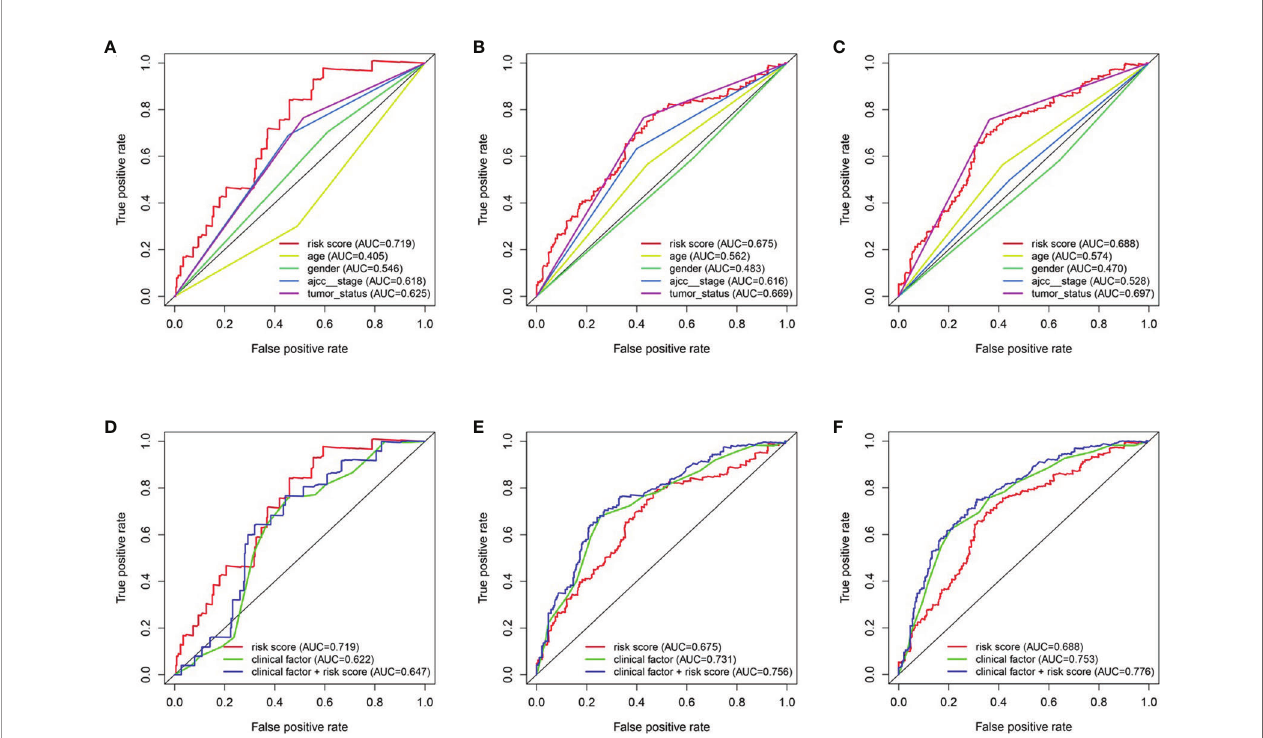
FIGURE 8 | The relationship between four genes mRNA signature and different clinical features. (A, D) training cohort. (B, E) testing cohort. (C, F) entire cohort.